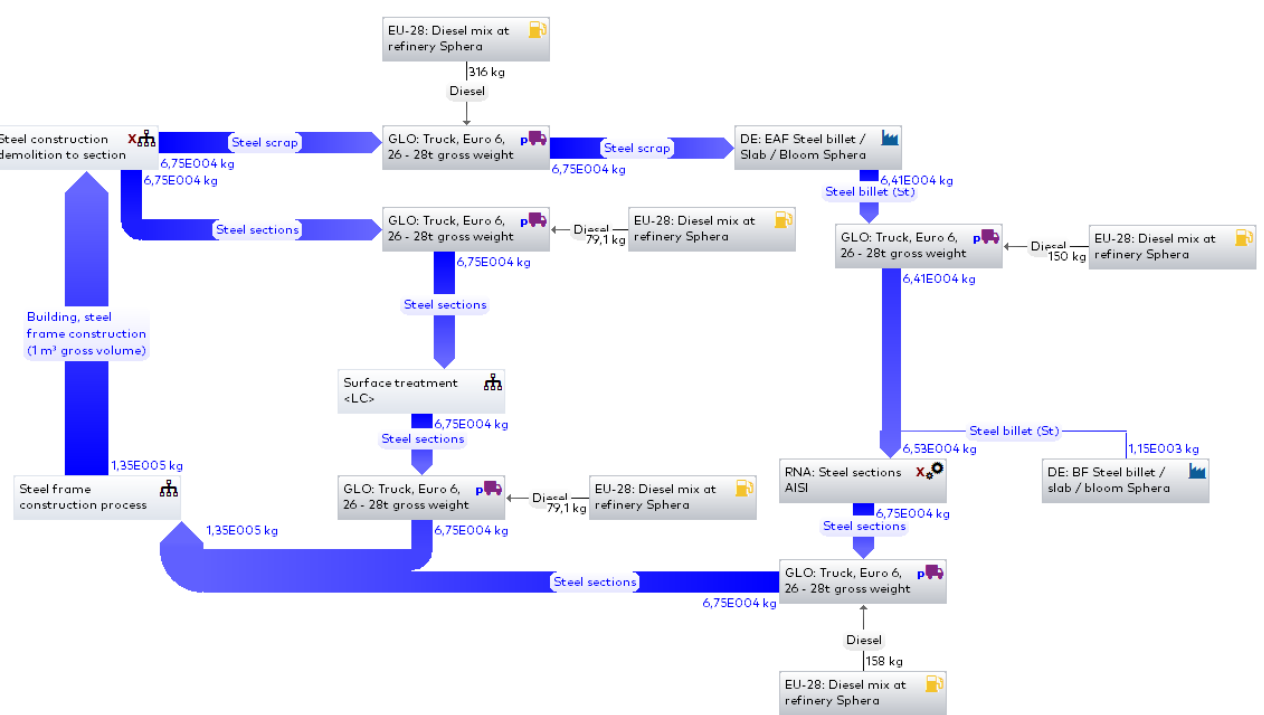
Figure 5. Scenario no. 1: Remelting the entire structure.